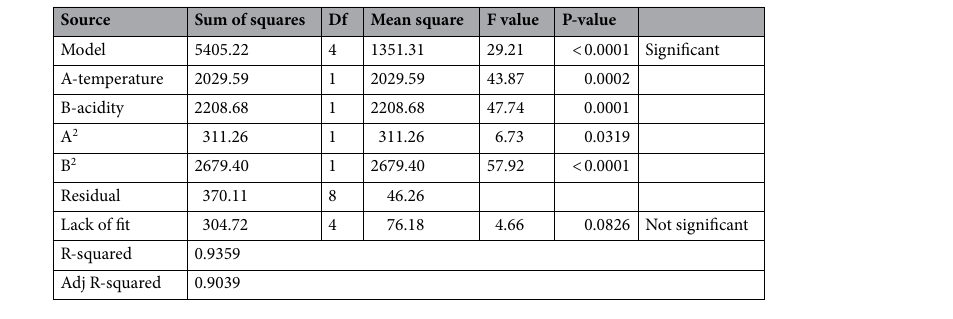
Table 6. ANOVA for the regression quadratic model of CCD